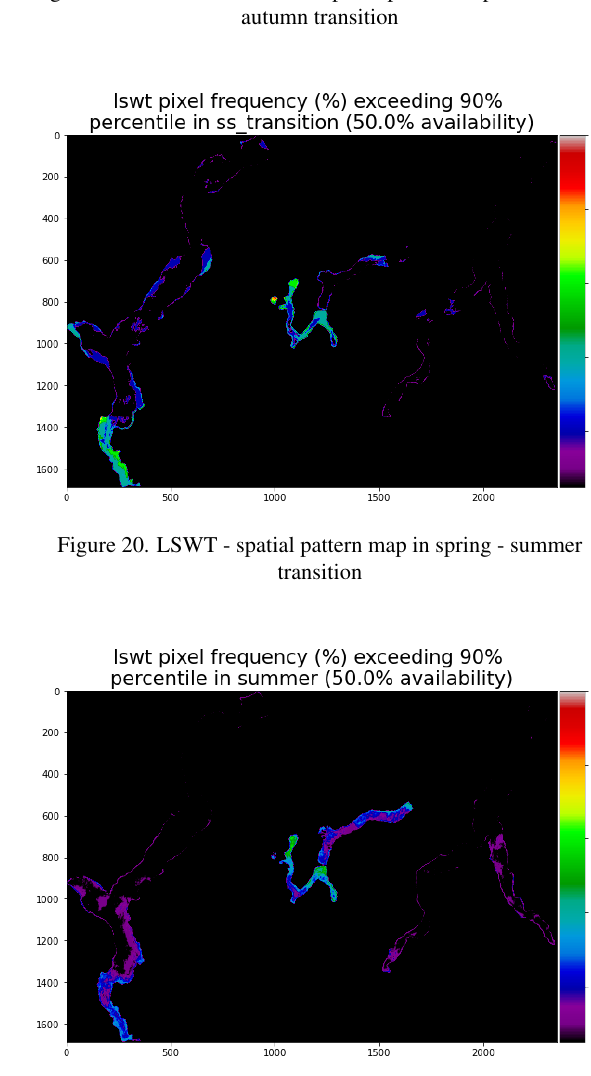
Figure 21. LSWT - spatial pattern map in